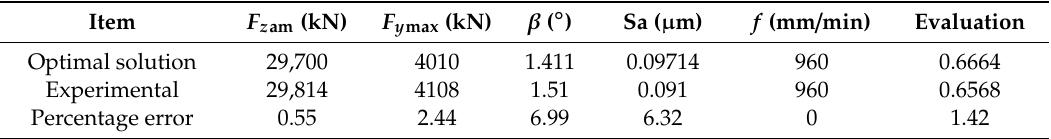
Table 8. Optimal solution and confirmation experiment results.